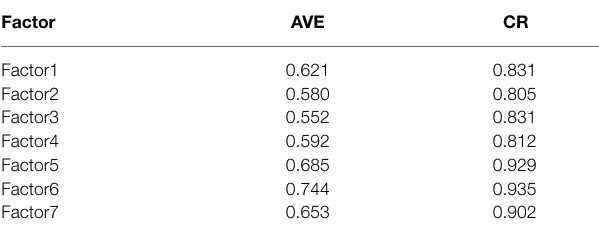
TABLE 4 | CR and AVE values of each factor.